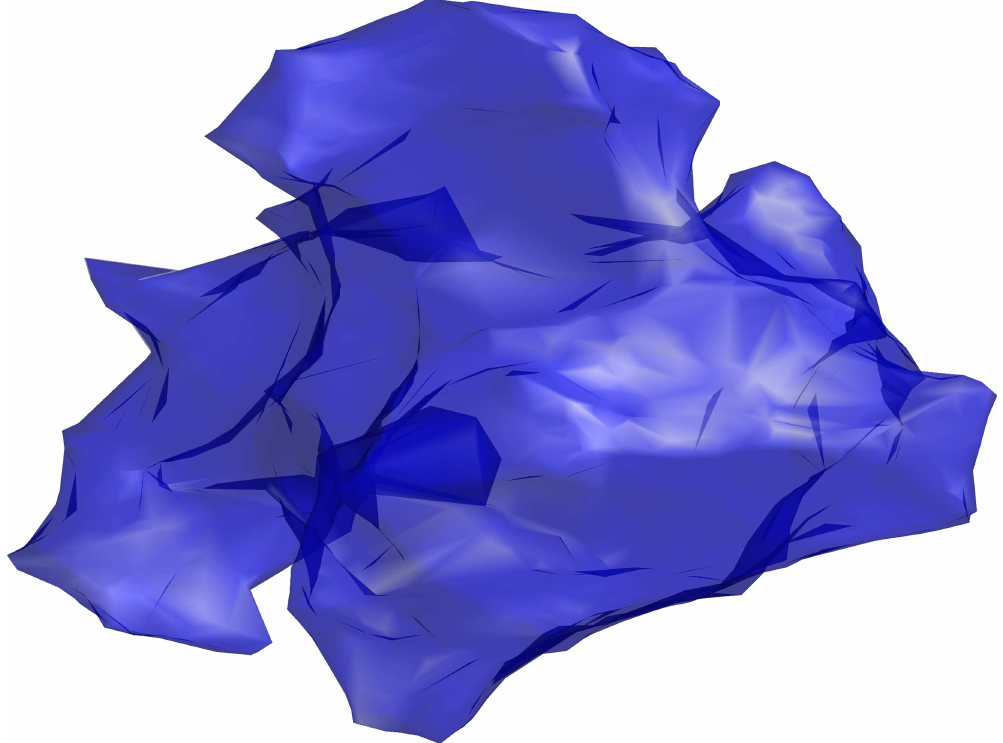
Fig 3. Tumour shape. The shape of the tumour generatedthrough triangulation. The total volume of the irregular tumour is 127 cm 3 .